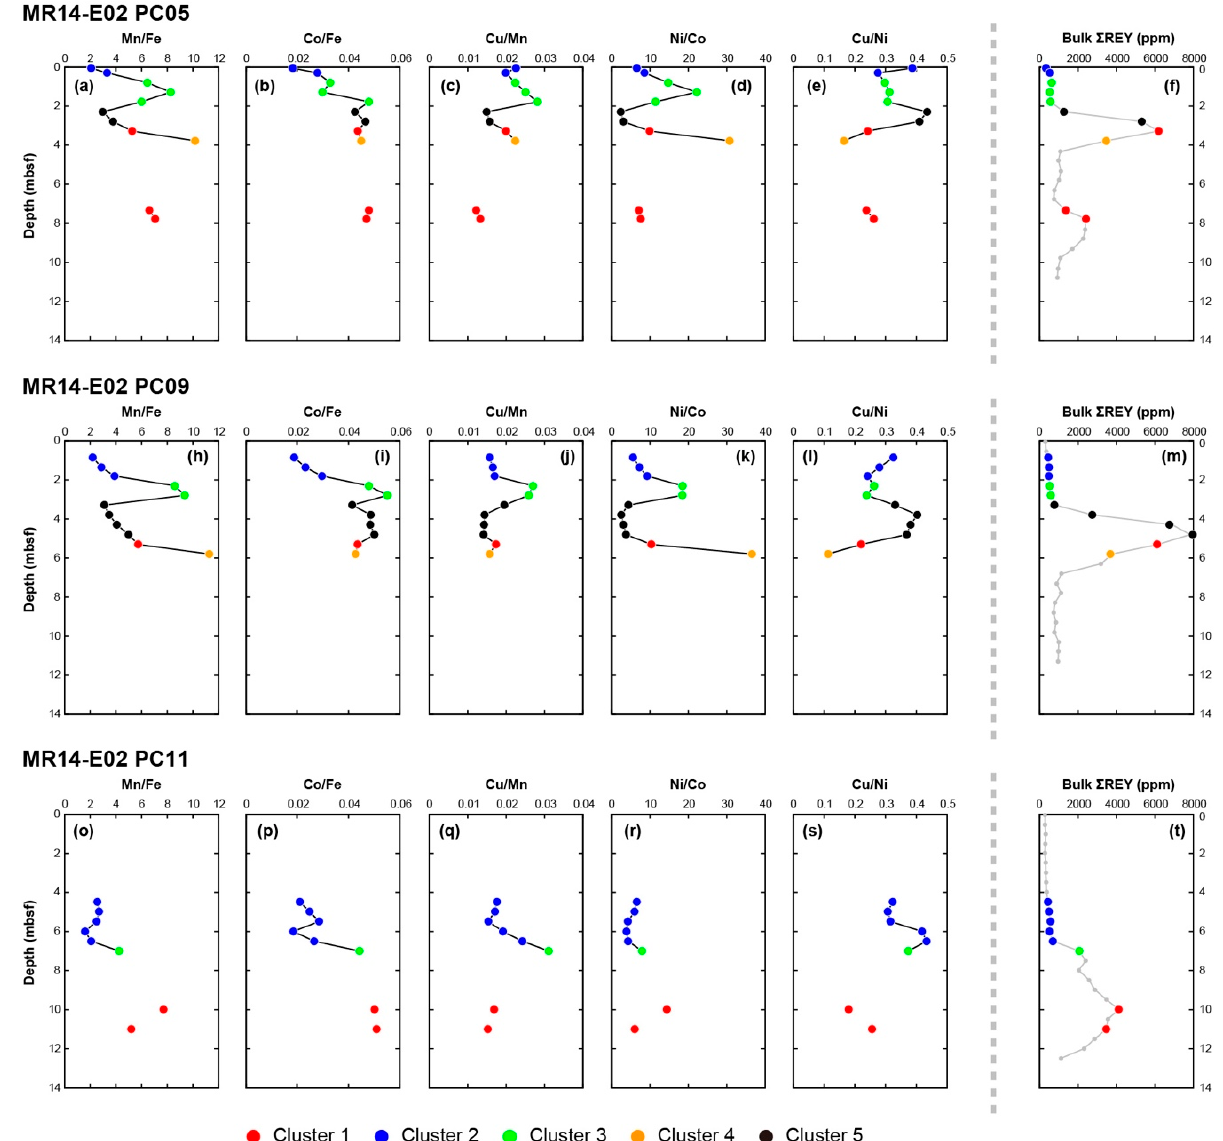
Figure 6. Downcore variations of the key element ratios colored by clusters ( K = 5) ( a – f , h – m , o – t ). The Σ REY contents of the bulk sediments and the clustering are also shown for comparison ( f , m , t ). The color-coding of the data points is the same as that in Figure 4.